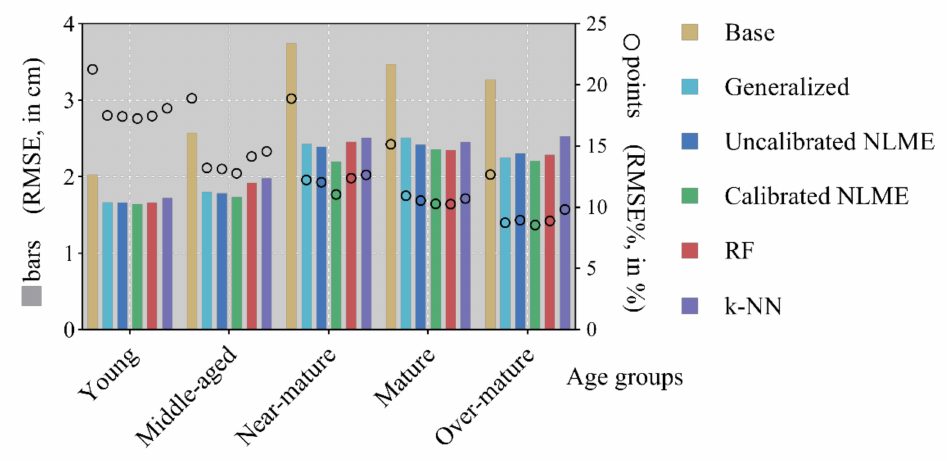
Figure 7. The root mean square error (RMSE) and relative RMSE (RMSE%) of the six methods across different age groups. The left axis represents RMSE (bars) in cm and the right axis represents the RMSE% (points) in